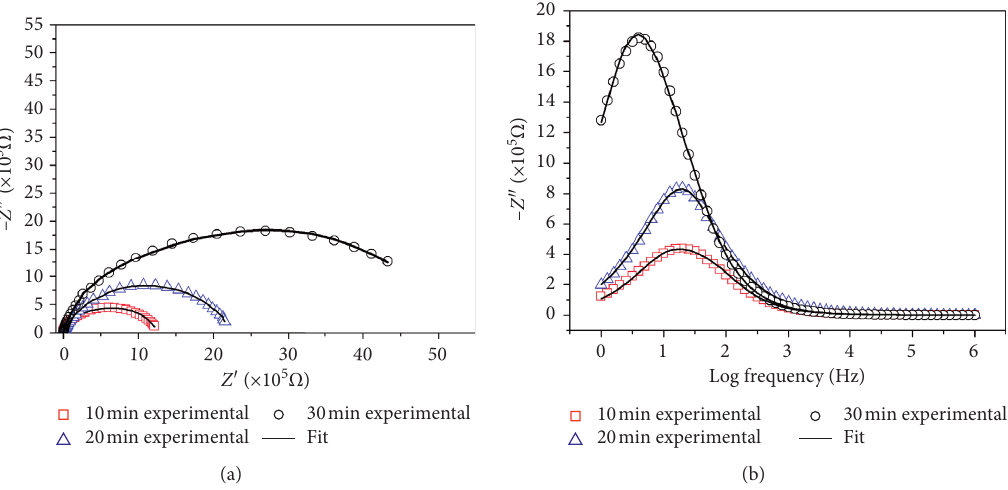
Figure 6: (a) Nyquist plot and (b) bode plots in the frequency range from 1Hz to 1MHz of heterojunction at different time periods of deposition of ZnO solid line represent the fit.